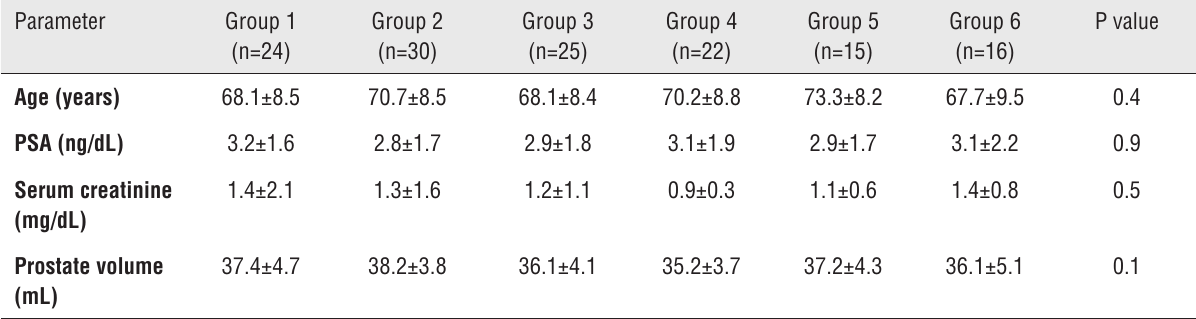
Table 1 - Demographic data of groups.